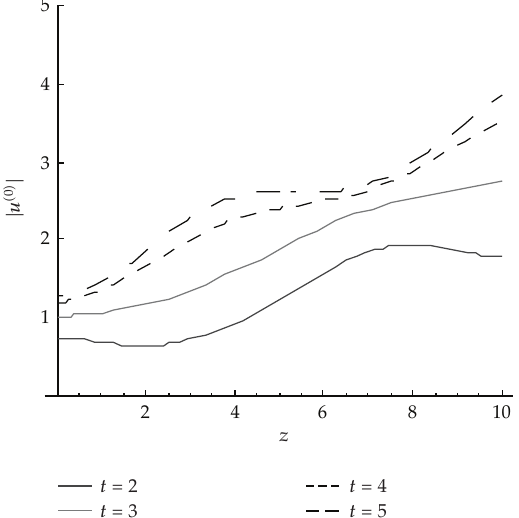
Figure 38: The first-order approximation | u (cid:3) 1 (cid:4) | at α (cid:8) 1, T (cid:8) 10, γ (cid:8) 0, ε (cid:8) 05 for di ff erent values of t , considering only one term in the series (cid:3) M (cid:8) 1 (cid:4)